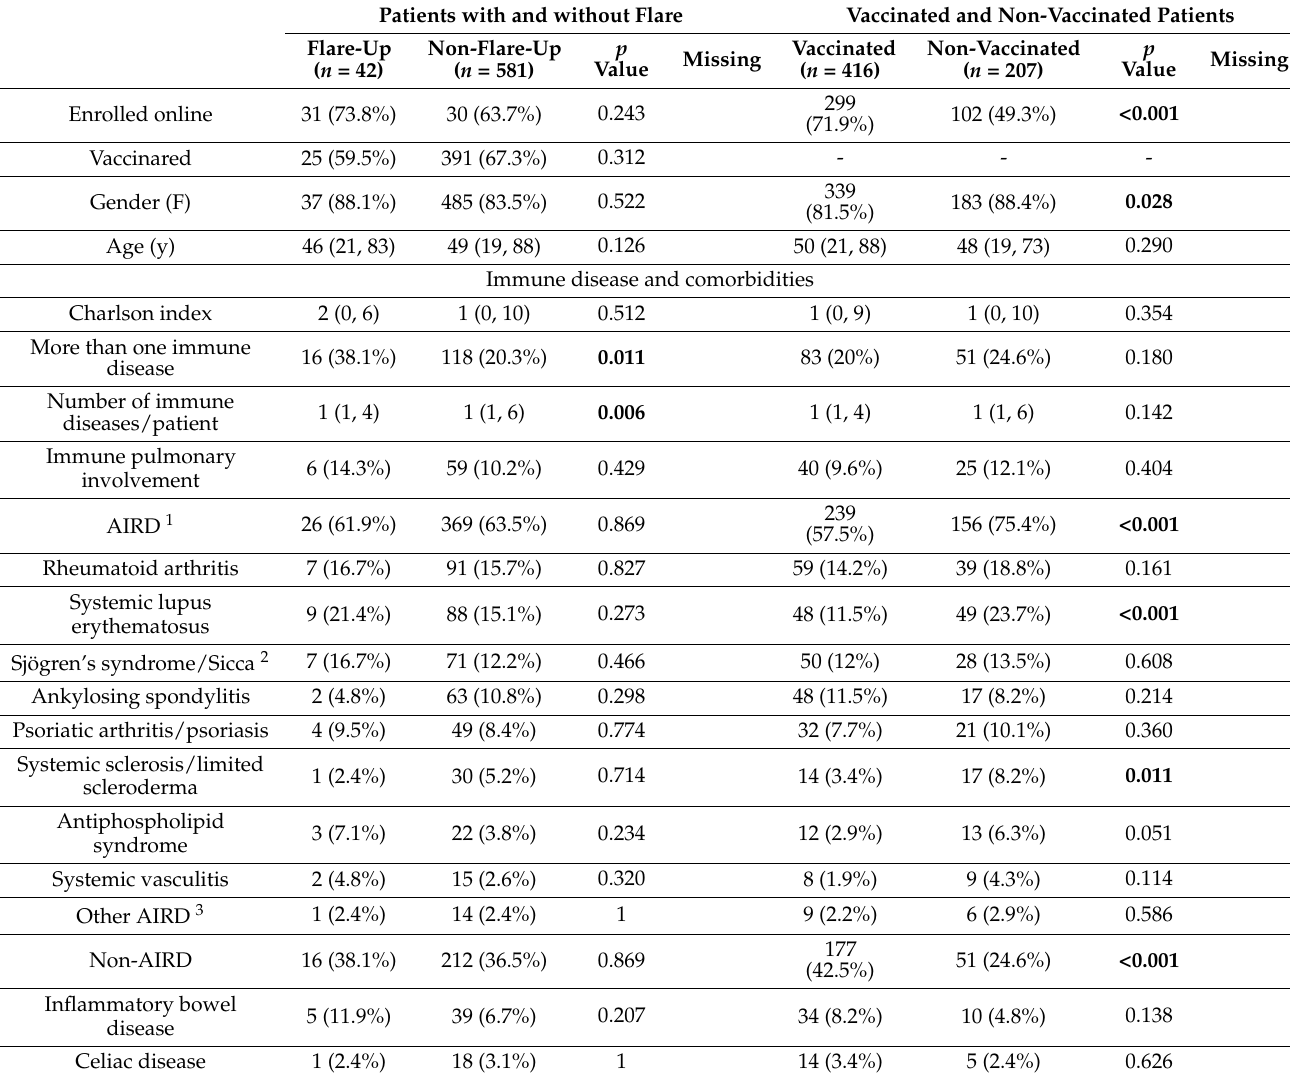
Table 1. The distribution of the variables in the flare-up and non-flare-up groups as well in the vaccinated/non- vaccinated